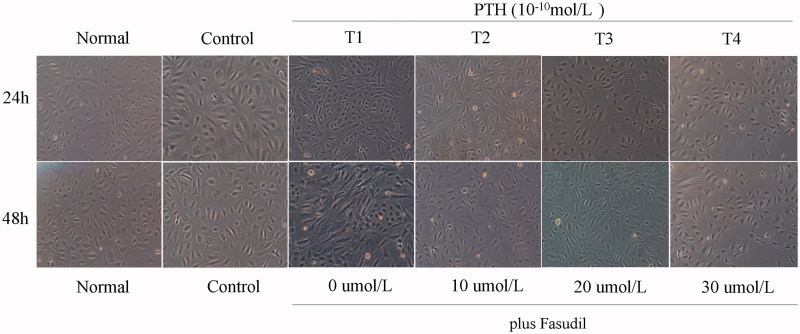
The impact of fasudil on cell morphology. HK-2 cells were treated with 0, 10, 20 and 30 ng/mL Fasudil in the presence of 10−10 mol/L PTH for 48 h. Cells were observed with an inverted microscope at 100× magnification.